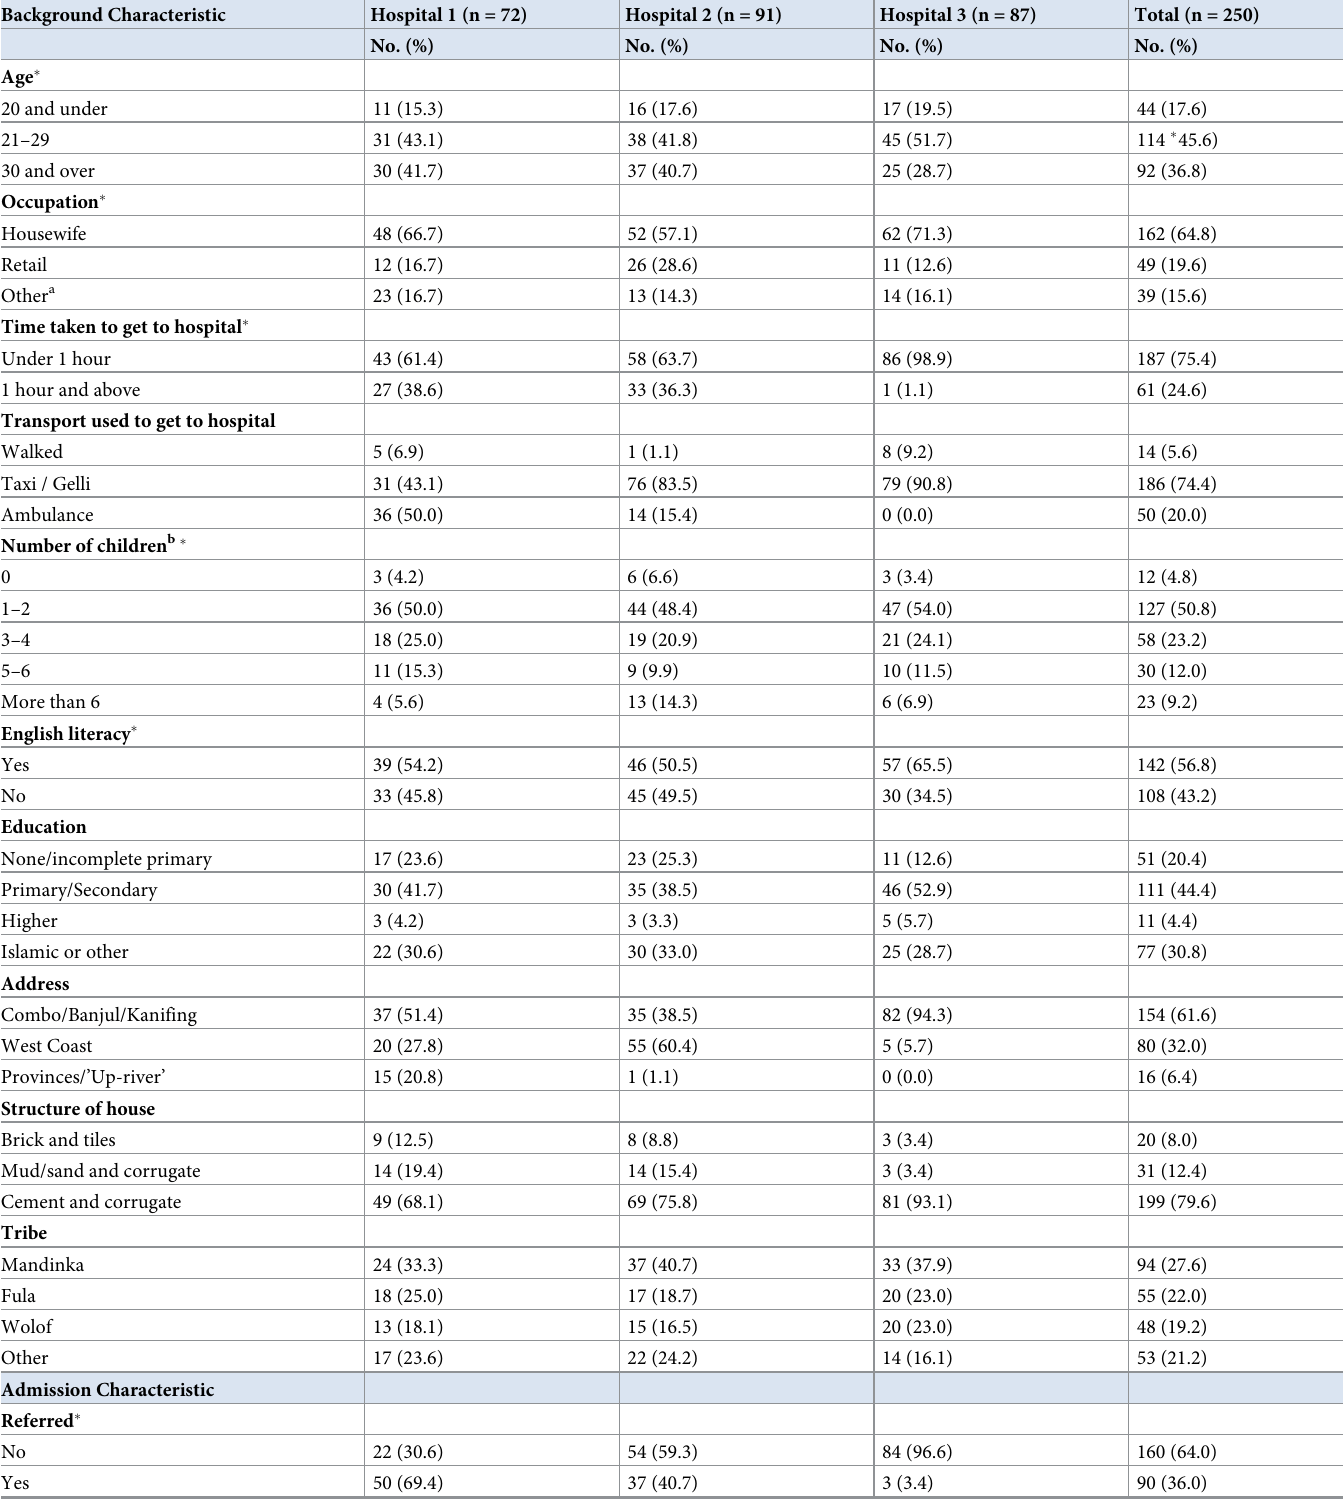
Table 1. Women’s demographic and admission characteristics across the three hospitals study